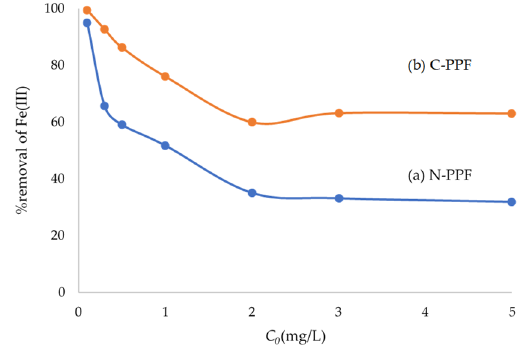
Figure 7. Impact of initial concentration of Fe(III) on adsorption onto both